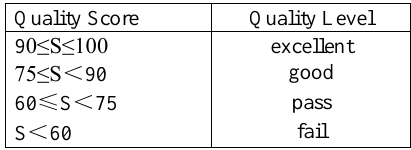
Table 4 . Settings for quality level classification.